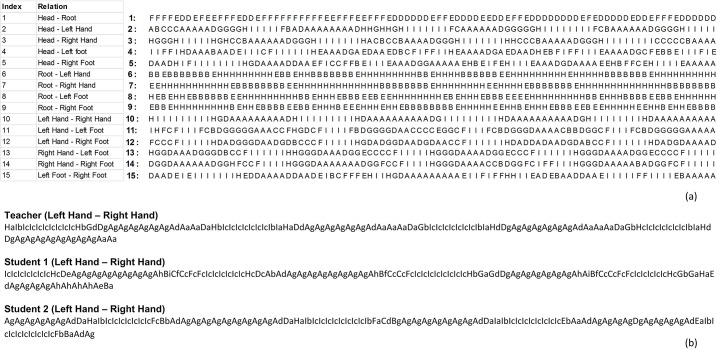
All QTCB movement sequences of the teacher during 3.64s of movement (a), QTCC movement sequences of the hands of the teacher, student 1, and student 2.